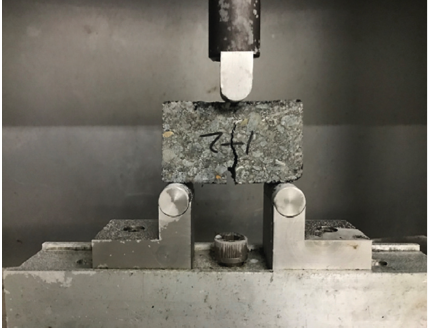
Figure 7: Three-point bending